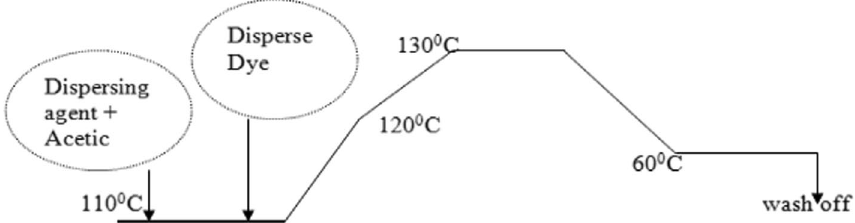
Fig. 1 Dyeing curve of treated polyester/cotton blend